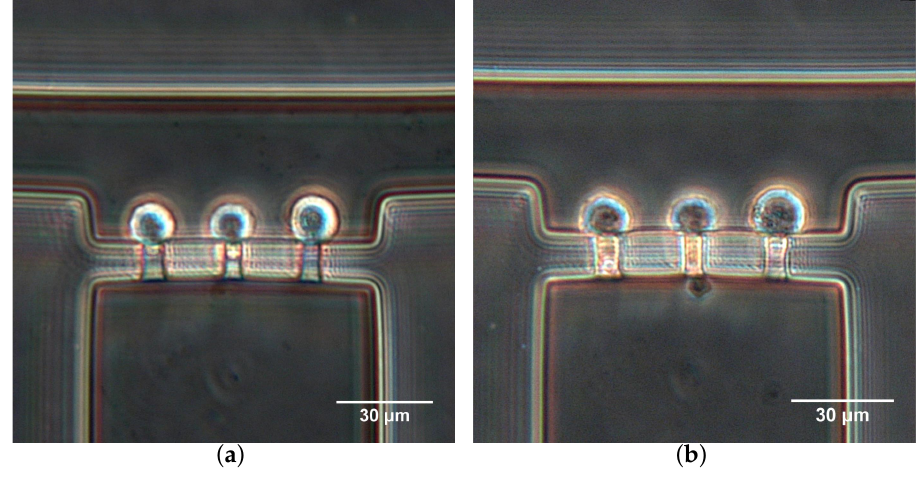
Figure 8. Hela cells aspirated into the micropipette aspiration channels at ( a ) Q t = 40 µ L/h and ( b ) Q t = 30 µ